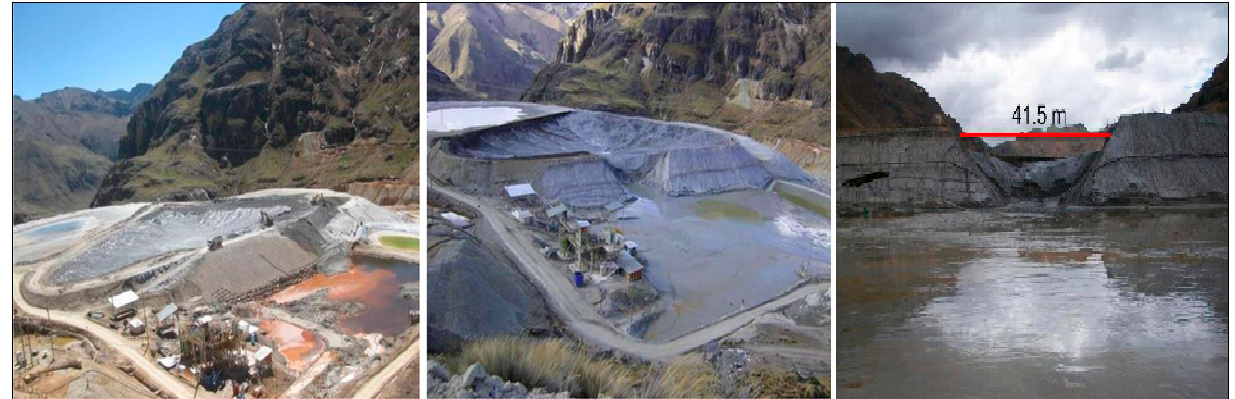
Figure 4. Breaking of the Tailings Dam A—Caudalosa Mine [42,43].